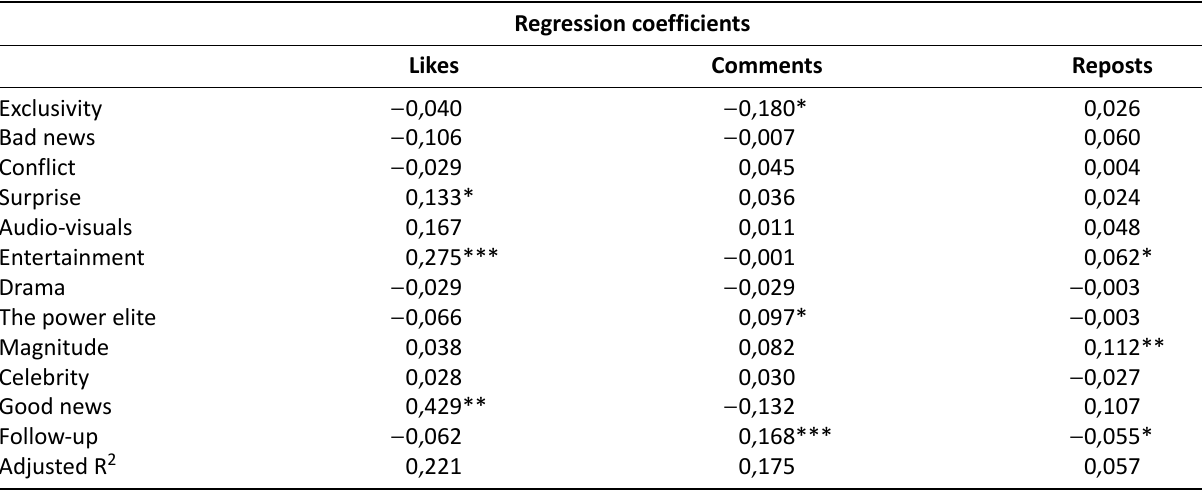
Table 4. Multiple regression models testing news values for likes, reposts and comments: Private-owned